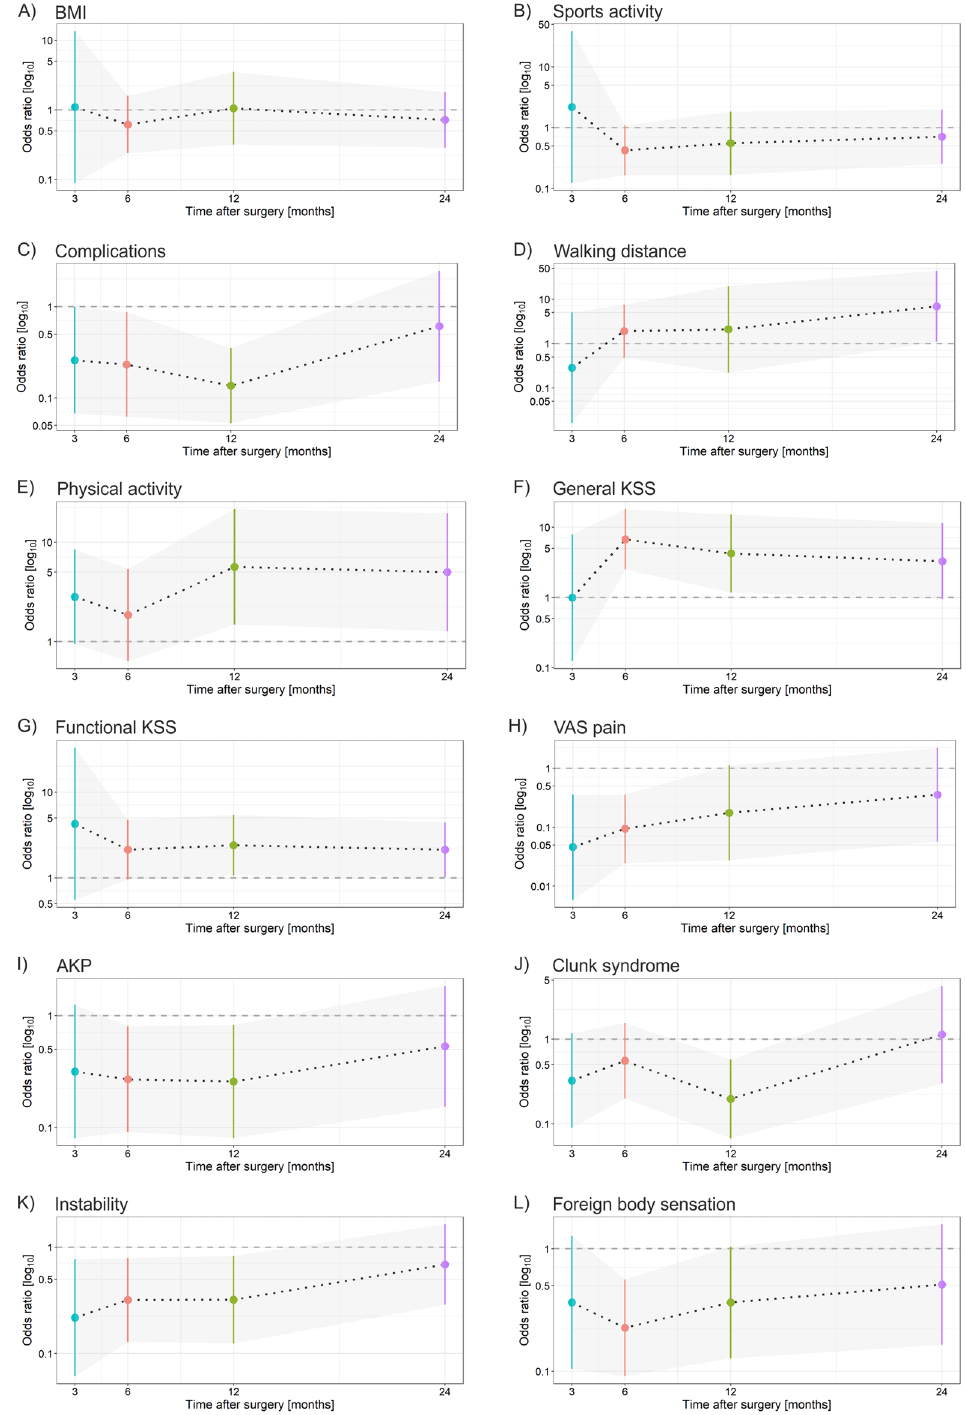
Figure 2. Contribution of postoperative factors to the likelihood of satisfaction in men in the 2 years after TKA. ( A ) BMI, ( B ) sports activity, ( C ) complications, ( D ) walking distance, ( E ) physical activity, ( F ) general KSS, ( G ) functional KSS, ( H ) VAS pain, ( I ) AKP, ( J ) clunk syndrome, ( I ) instability, ( K ) foreign body sensation. Odds- ratio (marked by dots) values above 1 are associated with satisfaction; values below 1 are associated with not being fully satisfied. The bars represent odds ratios (95%CI, low–high